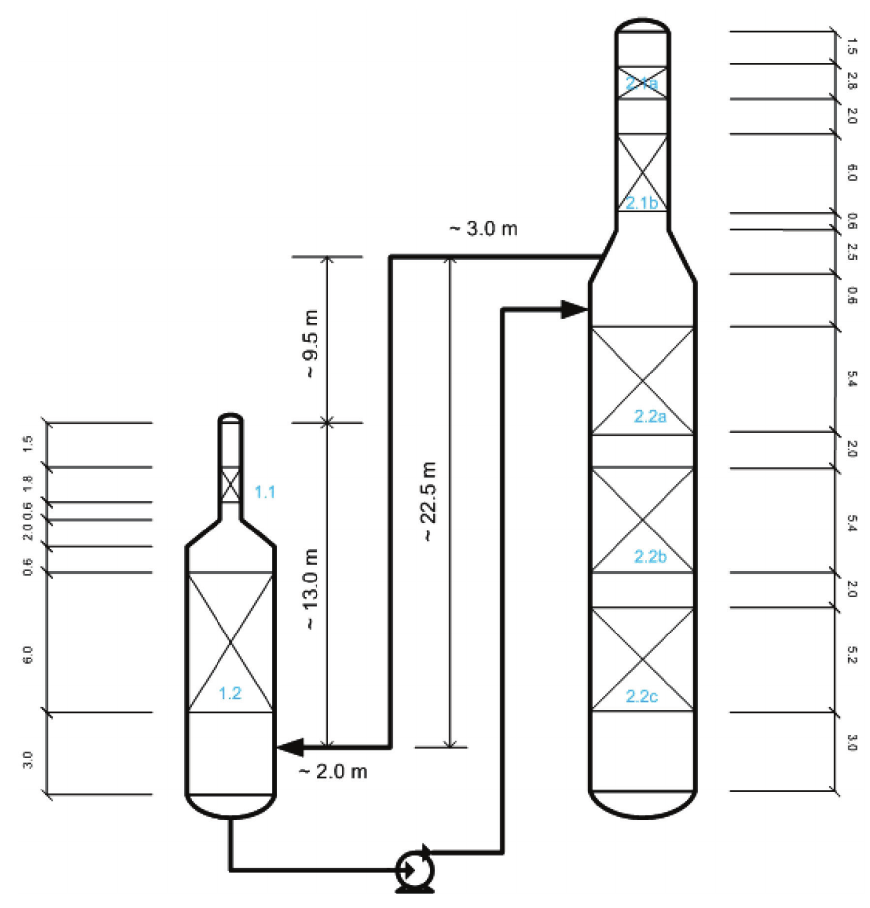
Fig. 6 – C2 and (C3+C4) columns positioning in TCDS arrangement indicating all rele- vant heights for pressure drop estimation in packed columns